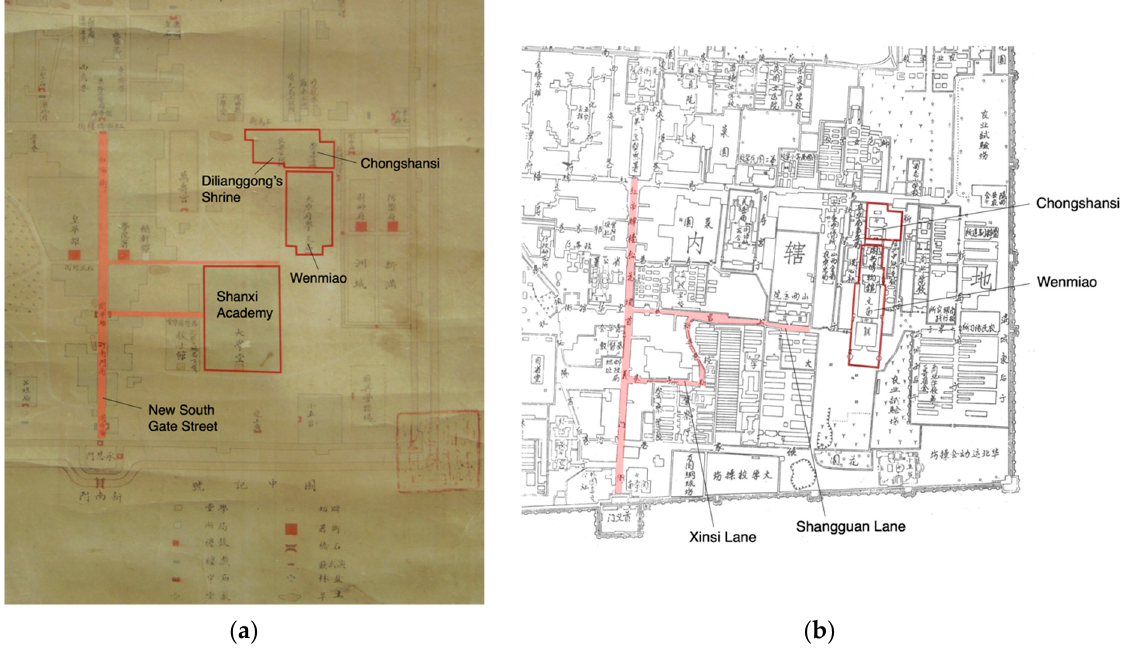
Figure 10. Chongshansi, Wenmiao, and Xinsi Lane in city maps: ( a ) Shanxi shengcheng quantui in 1904 (drawing by author based on Zheng 2004, p. 26); ( b ) Shanxi shengcheng xiangtu in 1919 (drawing by author based on Taiyuan Shi Nancheng Qu Renmen Zhengfu 1987, Appendix